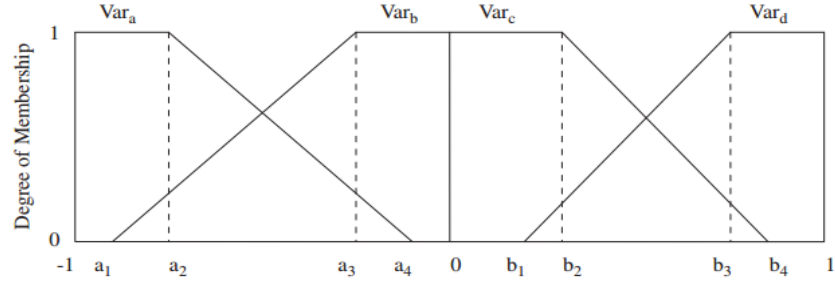
Figure 3. Trapezoidal Membership Function for the Input Linguistic